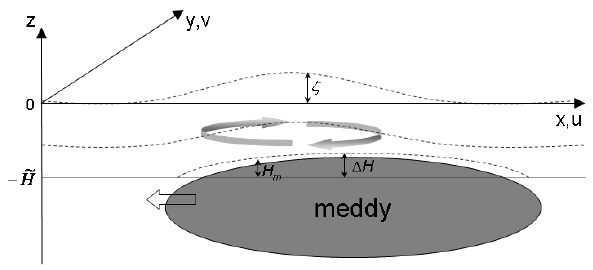
Fig. 4. Schematic view of generation of a surface signal by a